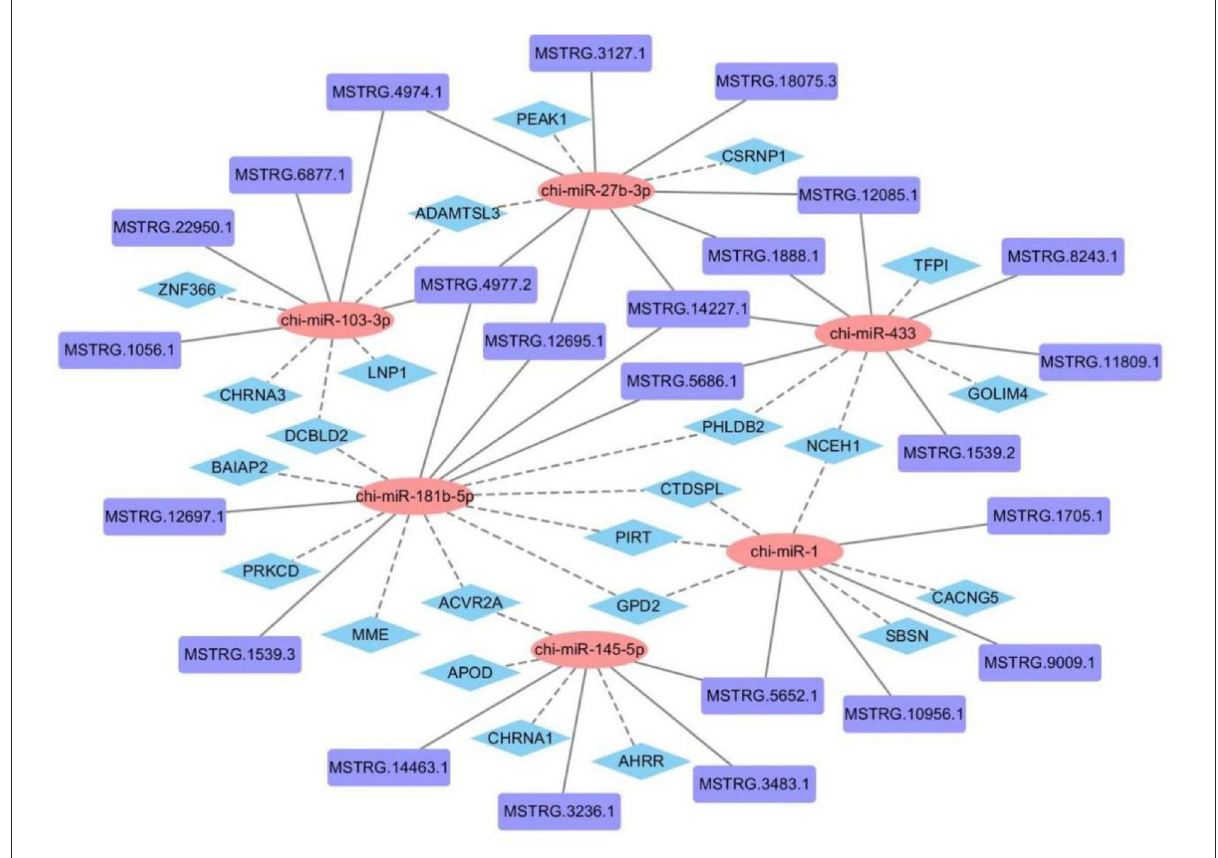
FIGURE9 Construction of lncRNA-miRNA-mRNA regulatory network related to hair follicle development in Inner Mongolia cashmere